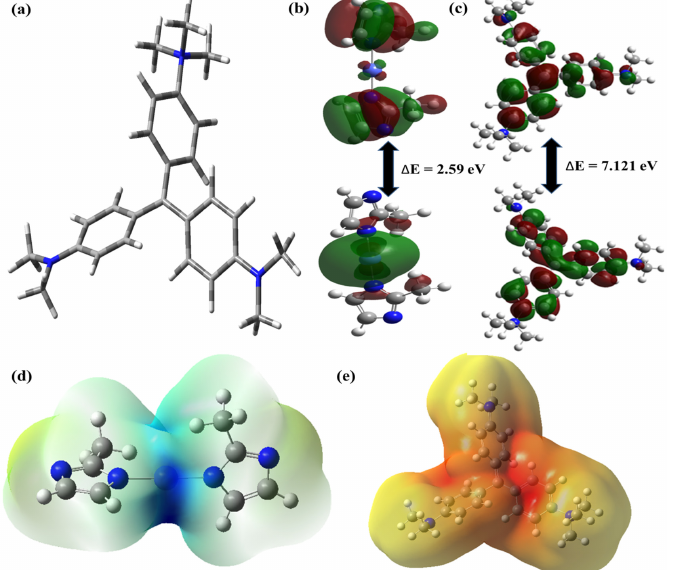
Figure 5. Optimized structure of MG ( a ), Frontier Molecular Orbitals (HOMO and LUMO) of ZIF-67 ( b ), Frontier Molecular Orbitals (HOMO and LUMO) of Methyl green ( c ), molecular elec- trostatic potential surface of ZIF-67 and MG ( d , e ) respectively.